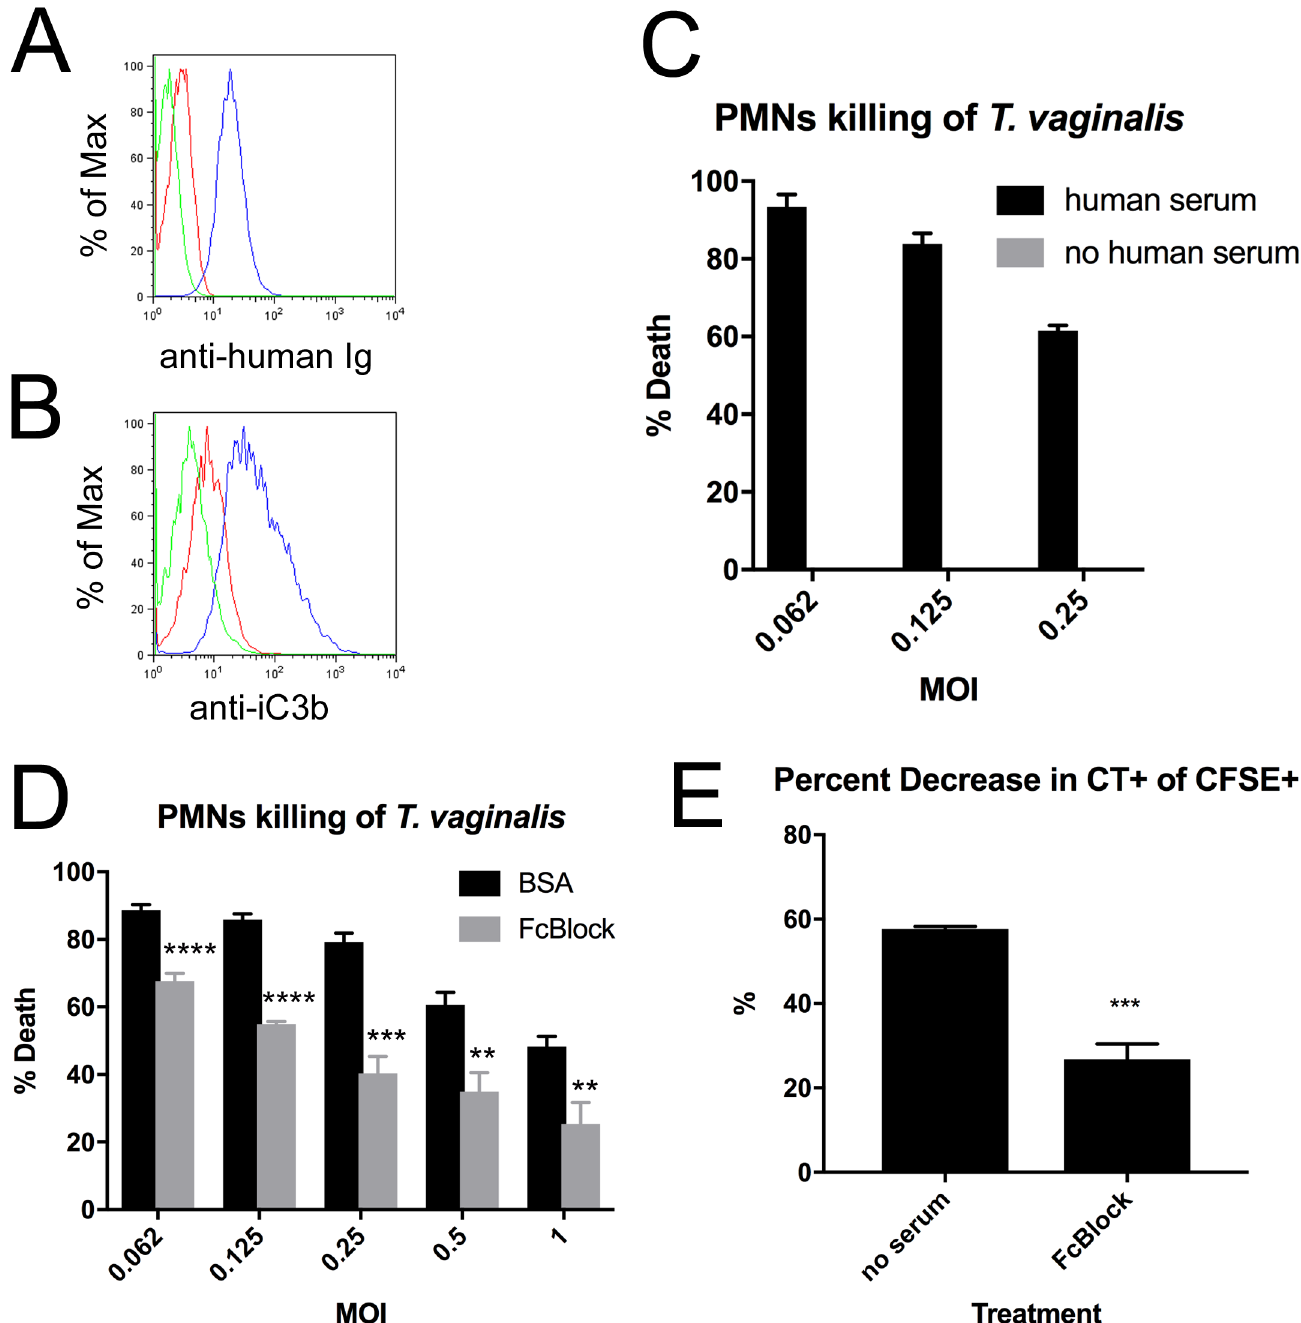
Fig 6. Human serum factors are required for PMN killing of T . vaginalis . (A, B) T . vaginalis were stained with 100% human serum, followed by (A) antihuman immunoglobulin light chain kappa or (B) antihuman iC3b, and analyzed with flow cytometry. Green = unstained, red = secondary only (A) or isotype control (B), and blue = fully stained. (C) T . vaginalis cytotoxicity assay was performed as in Fig 1, either in the presence or absence of 10% human serum. (D) T . vaginalis cytotoxicity assay was performed in the presence of 8-ug/ml human IgG Fc fragment or equivalent BSA control. (E) Percent decrease in CT + events within total CFSE + events after T . vaginalis cytotoxicity experiments in (C) and (D). All data are represented as mean ± SD of triplicate wells and representative of 3 donors and 3 independent experiments. Underlying data can be found in S1 Data and S5–S8 FCSfiles. BSA, bovine serum albumin; CFSE, Carboxyfluorescein succinimidyl ester; CT, Cell Tracker; Fc, fragment crystallizable; FCS, fluorescence correlation spectroscopy; MOI, multiplicity of infection; PMN, polymorphonuclear cell.